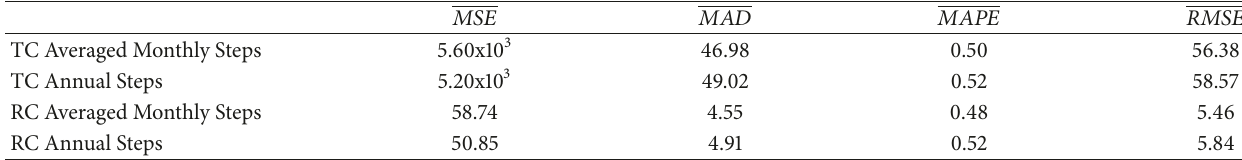
Table 3: Average of main measures of error for GBM after 1000 MC simulations from 2013 to 2017.